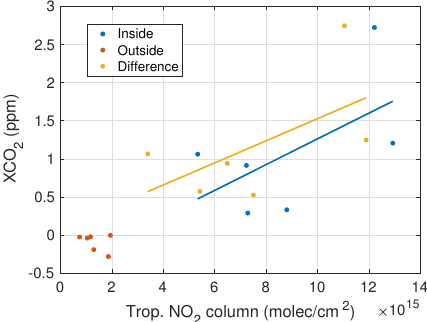
Figure 11. Scatter plot between the median XCO 2 anomalies and tropospheric NO 2 columns inside (blue dots) and outside (red dots) the NO 2 plumes. The difference between the values inside and outside the plume are also shown (yellow dots). The corresponding linear fits are also shown (blue and yellow line). The slope (CO 2 -to-NO 2 ratio) in both cases is ~1.5 × 10 − 16 ppm/(molec./cm 2